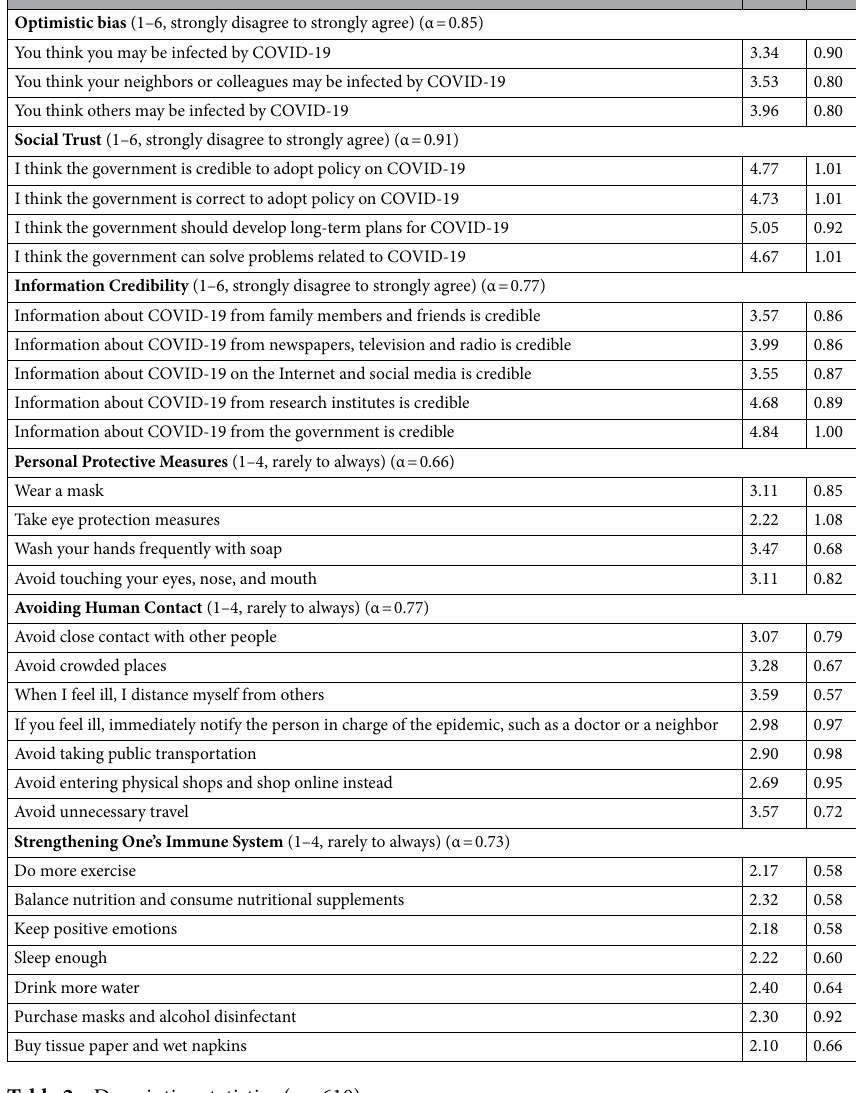
Table 2. Descriptive statistics ( n = 610).